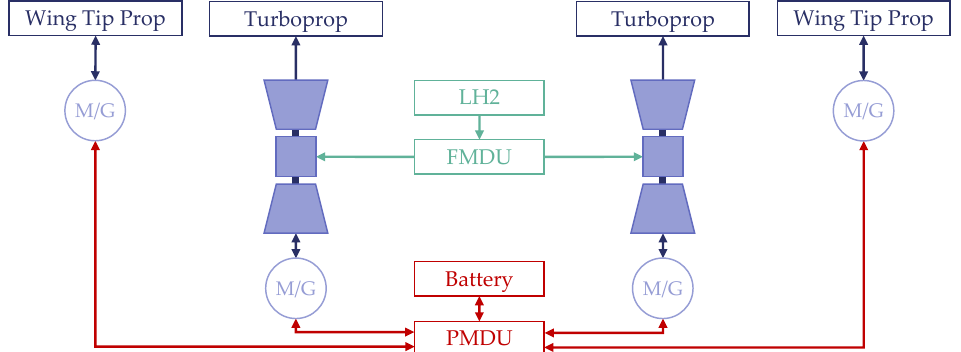
Figure A5. Architecture 5: Parallel hybrid-electric architecture with electric boosters and WTPs propelled by LH2.